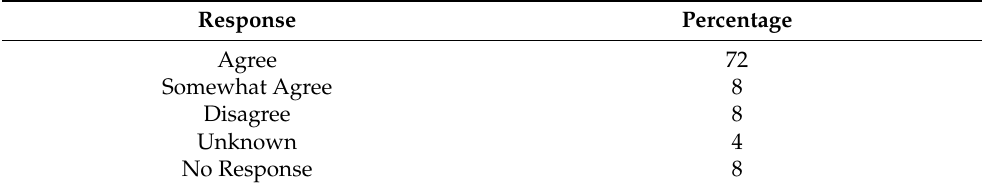
Figure 6. A schematic ring road with a width of about 70 m around a community that may poten- tially reduce wildland fire-induced risks. Table 3. Response summary about the construction of a ring road with a width of 70